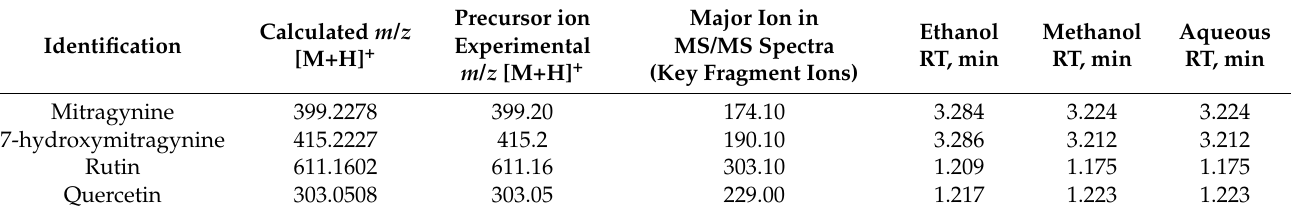
Table 2. MS/MS data of compounds identified tentatively in kratom ethanol, methanol, and aqueous leaf extracts using UHPLC and LC-MS/MS.